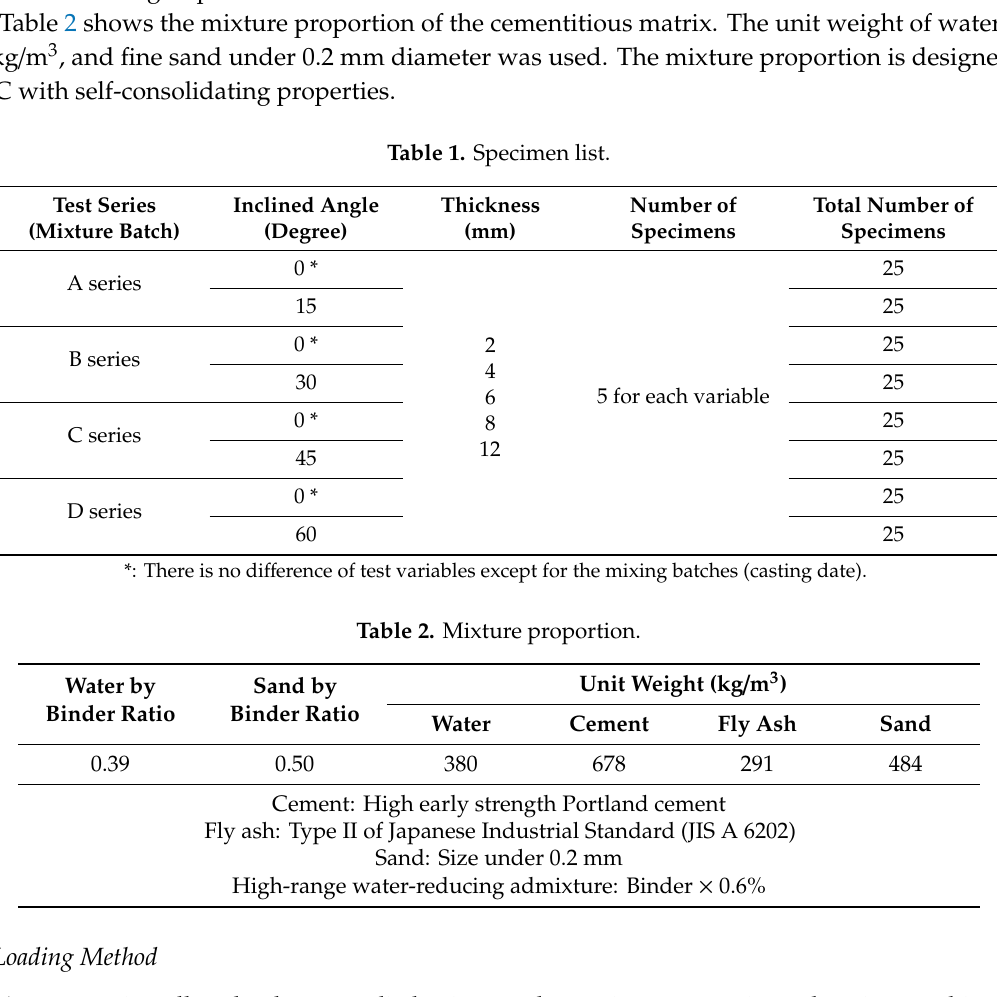
Figure 4. The specimen was fixed via an adhered steel plate, and the embedded fiber was clamped directly by a chucking jig. The length of fiber out of the matrix was 55 mm, and the gripping length of the fiber is equal to that of the jig. The head speed was set to 1 mm per minute. The pullout load and head displacement were